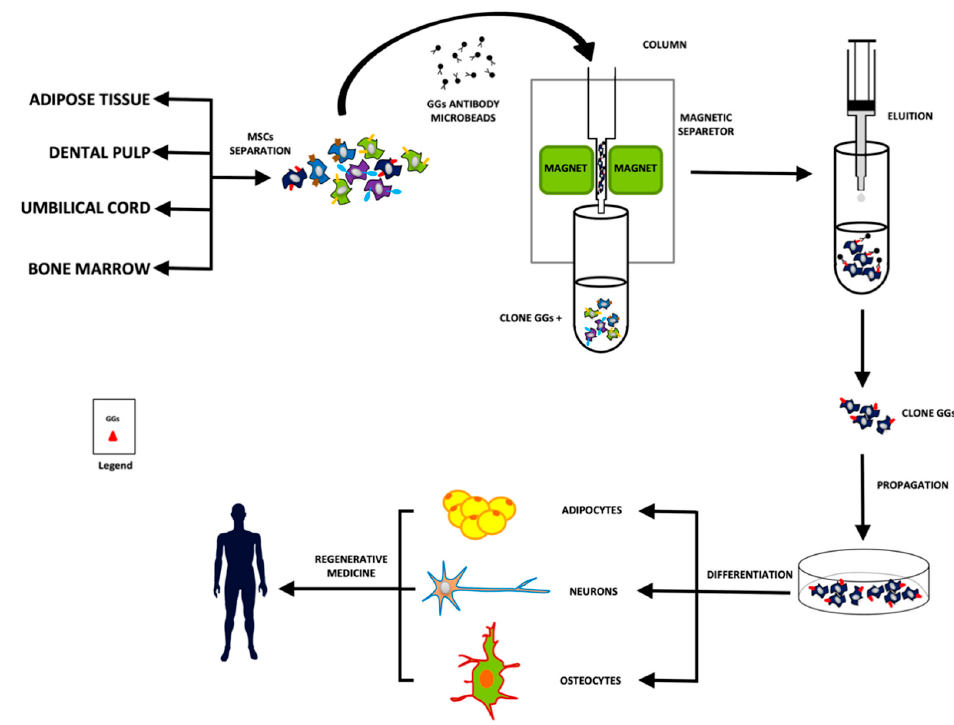
Figure 2. Schematic procedure for the separation of the specific clones of MSCs.